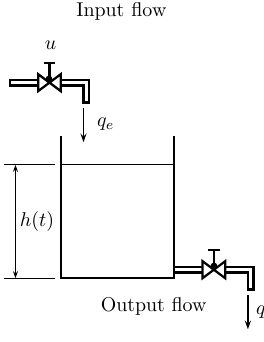
Figure 21. Tank filling system. Table 19. System parameter